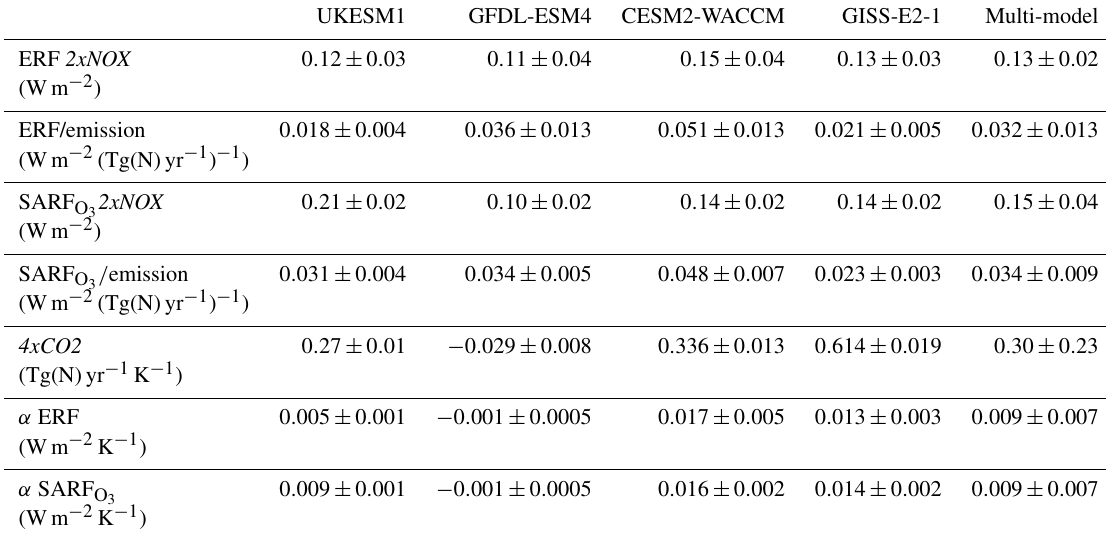
Table 11. ERF and ozone SARF radiative efficiencies for 2xNOX lightning NO x emissions. Changes in emissions are from the 4xCO2 experiment. α values are calculated assuming ERF or ozone SARF. Uncertainties for each model are errors in the mean based on interannual variability and assuming a 15% uncertainty in the ozone radiative efficiency (Sect. 2.2). Uncertainties in the multi-model results are the standard deviation across the